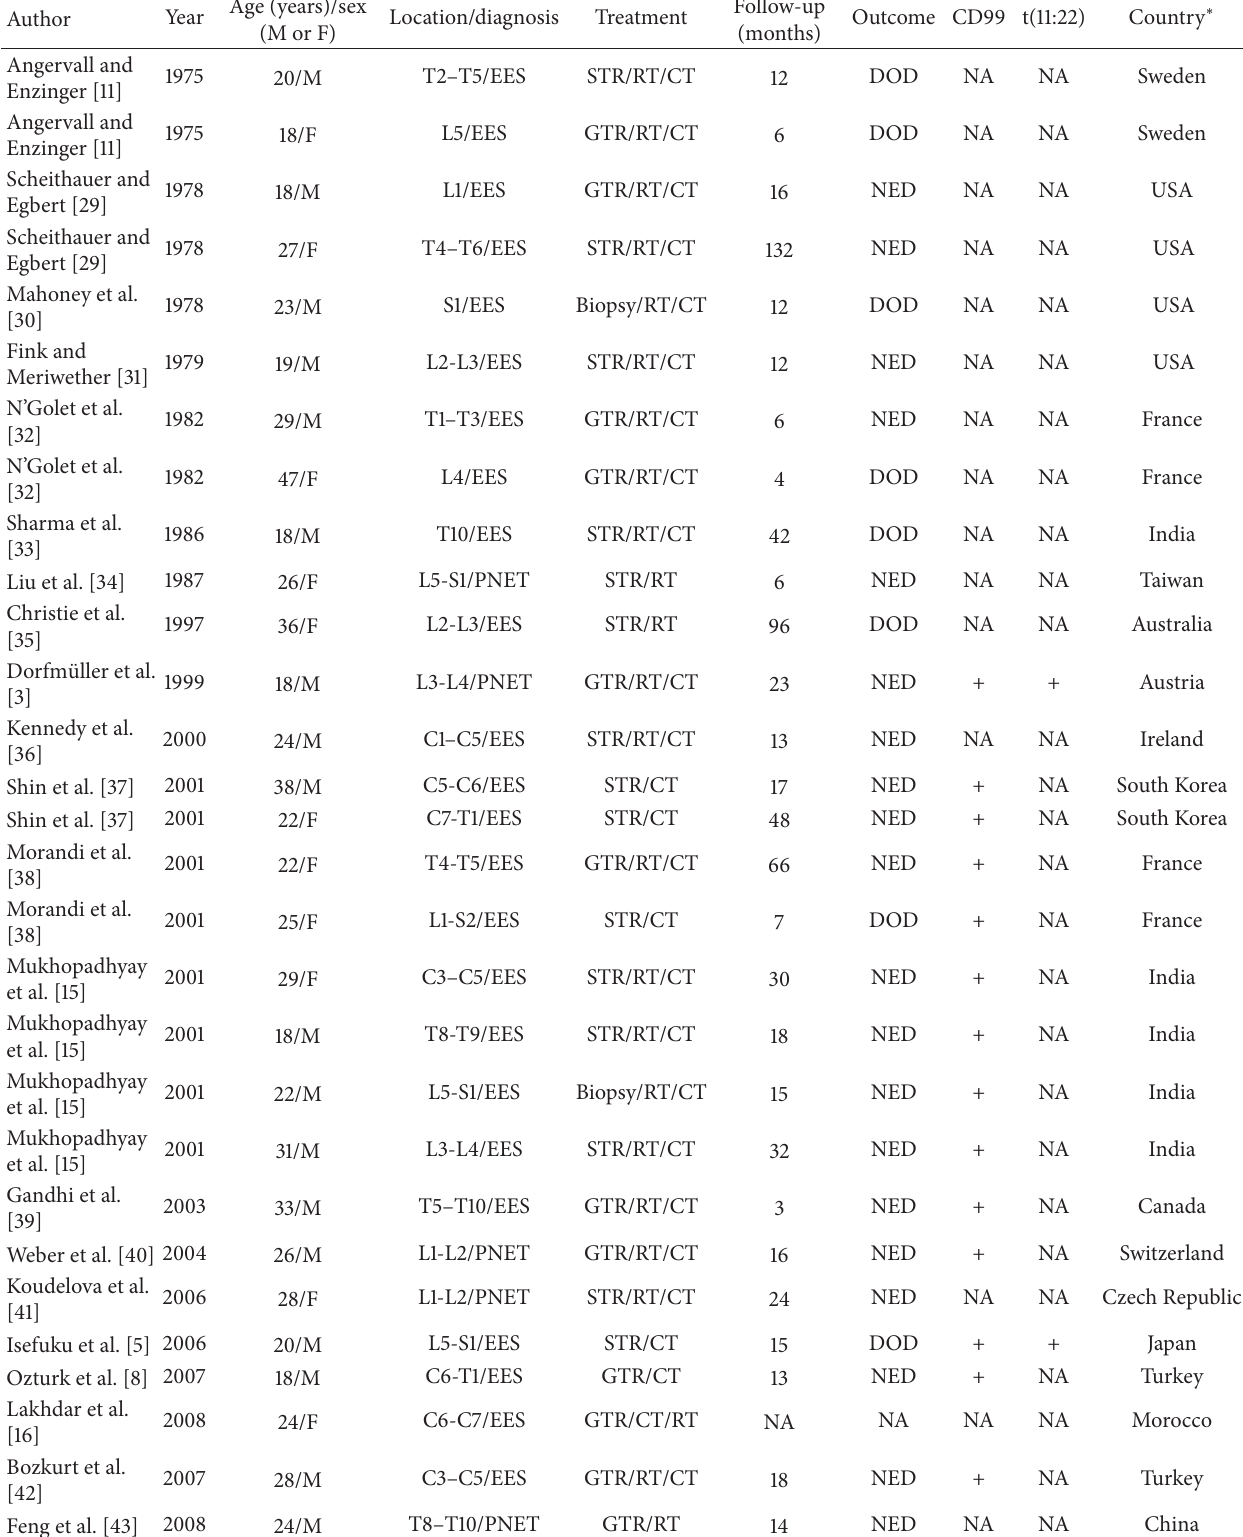
Table 1: Cases of adult primary spinal epidural EES/PNET tumors in the